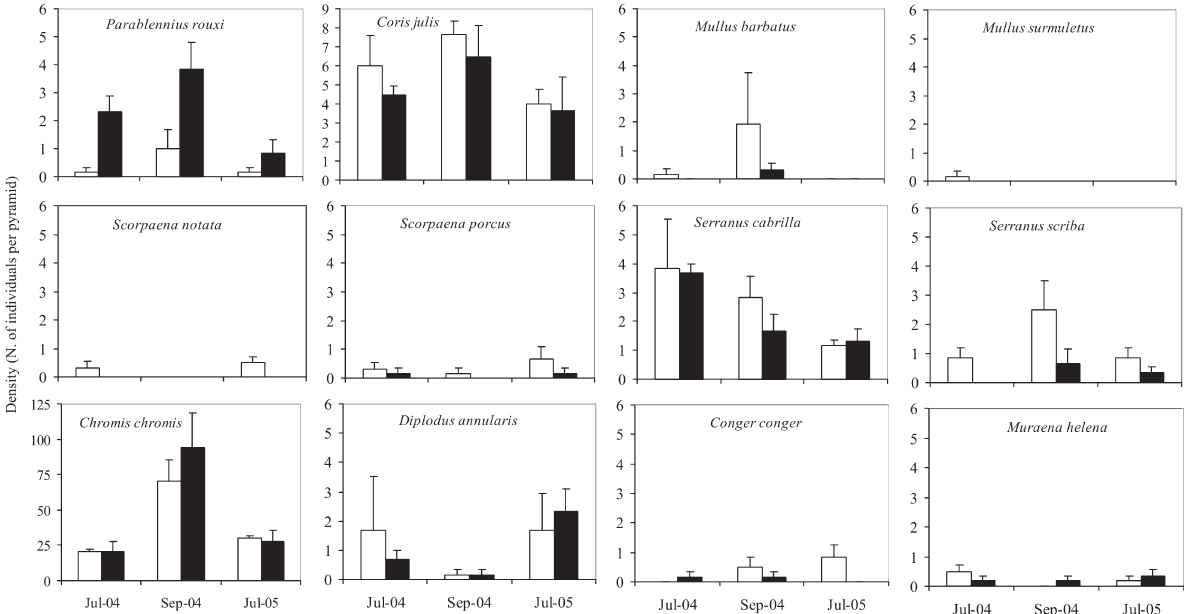
Fig . 3. – Mean (+SE) density (number of individuals per pyramid) of potential fish preys and competitors of E. marginatus recorded at Capo S. Marco (white bars) and Torre Verdura (black bars) according to sampling period. Table 3. – Results of ANOVA used to test for differences in the density of potential fish preys and competitors (in bold) of E. marginatus between the artificial reefs of Capo S. Marco (CSM-AR) and Torre Verdura (TV-AR). **P<0.01; NS non-significant (p>0.05). Parablennius rouxi Coris julis Mullus barbatus Effect df